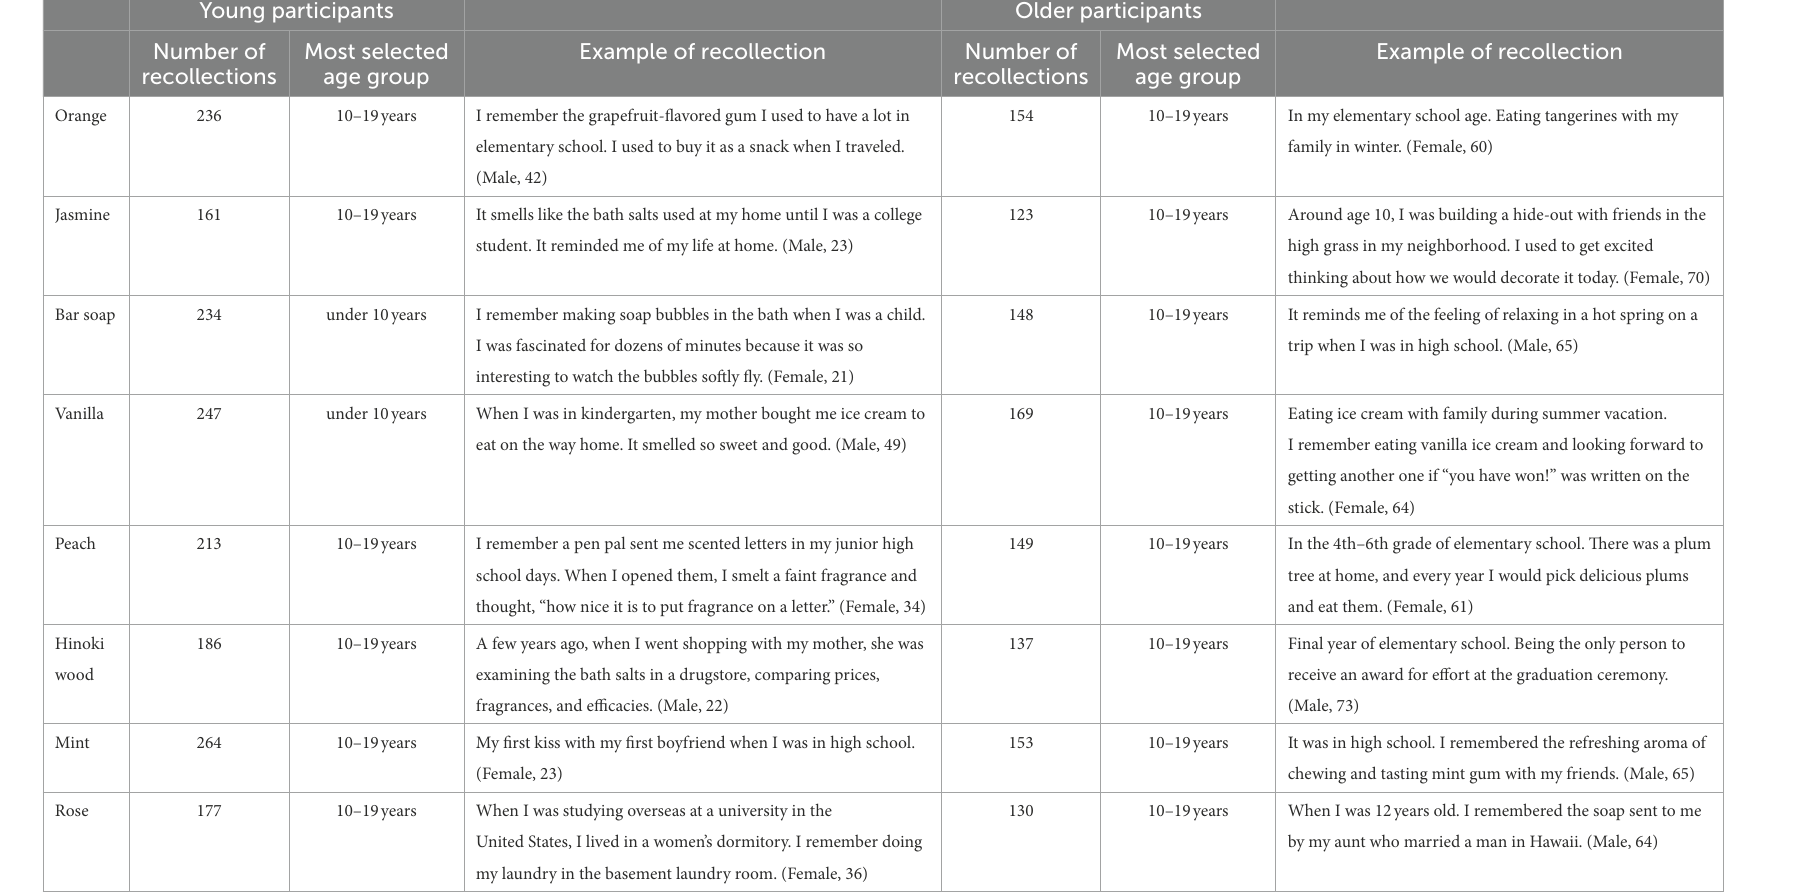
TABLE 2 Number of recollections, most selected age group, and examples of memory for each